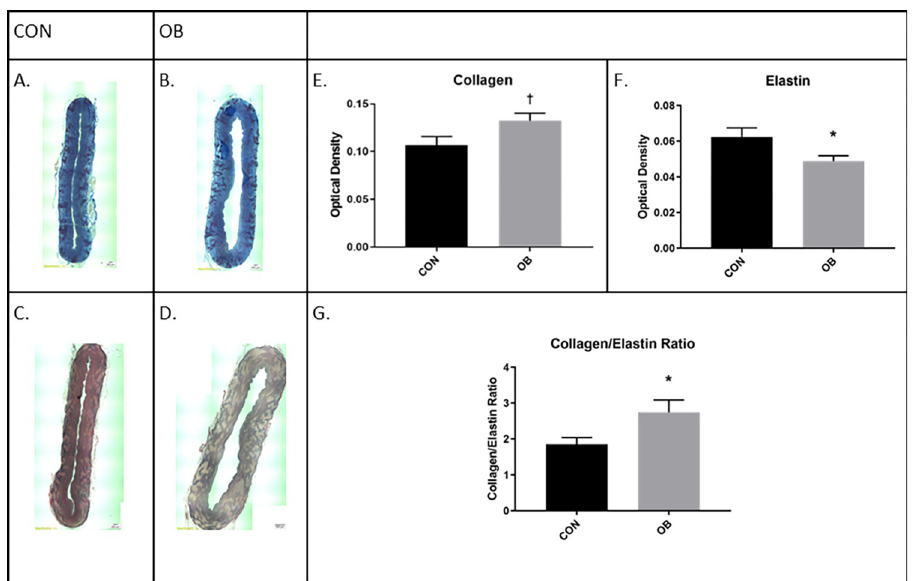
Fig 1. Fetal aorta sections. Masson trichrome and Van Gieson staining results from fetal aorta sections for CONF1 (n = 5) and OBF1 (n = 6) fetal aorta sections at dG 135. † means show a trend (p < 0.1) between groups. � means differ (p < 0.05) between groups.